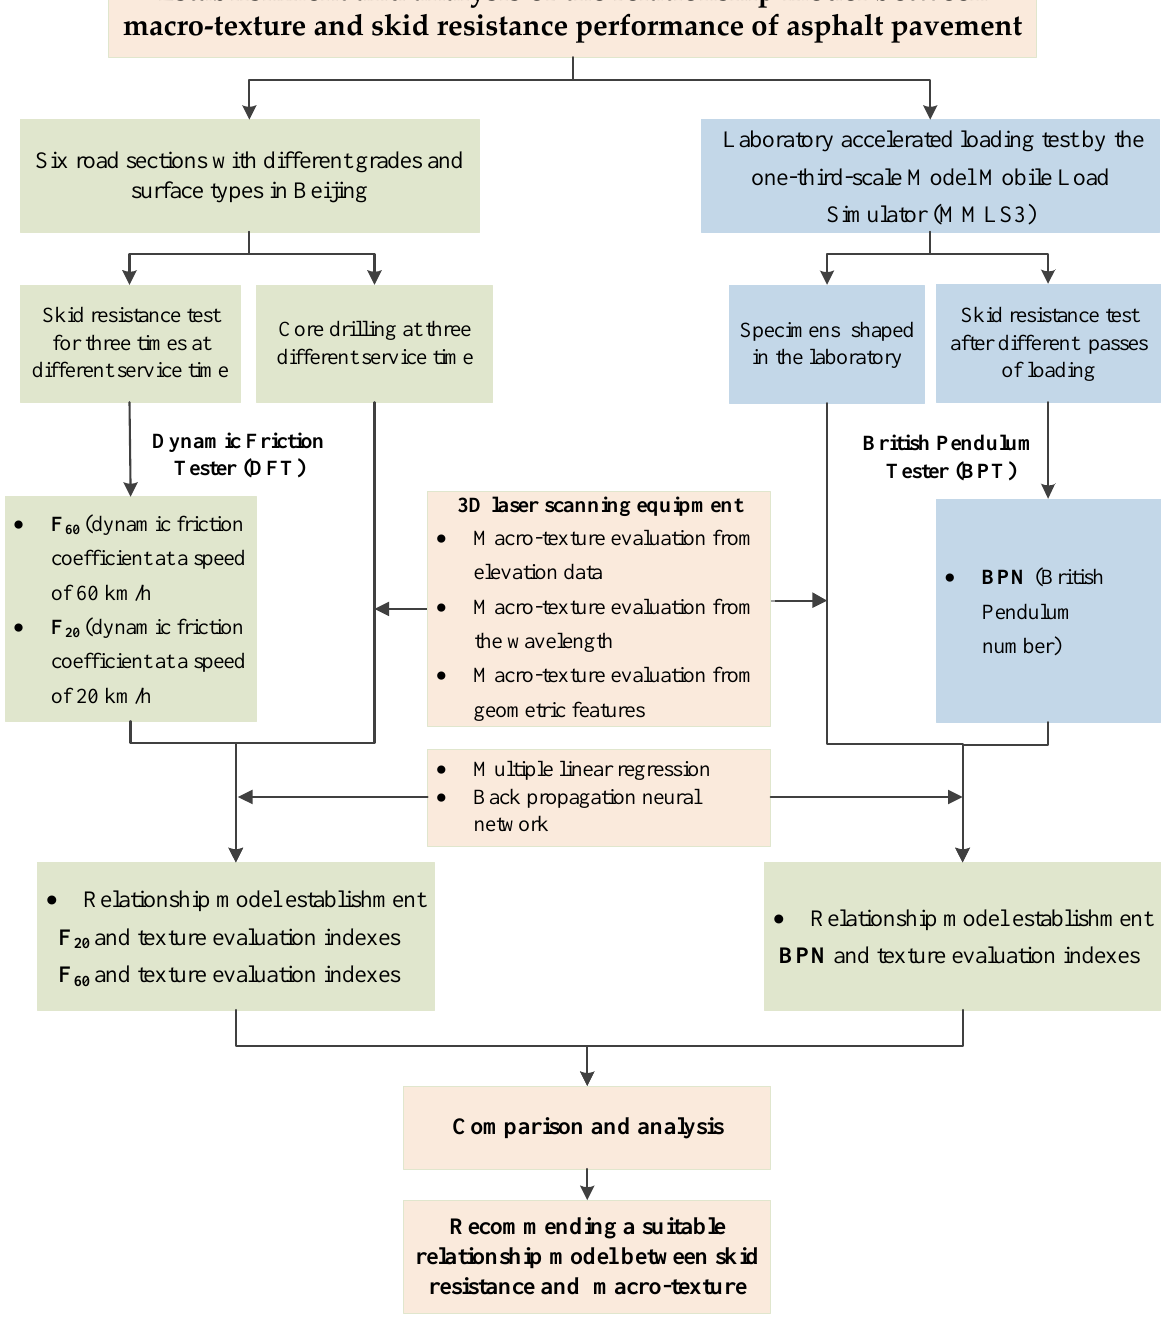
Figure 1. Flowchart of this study.